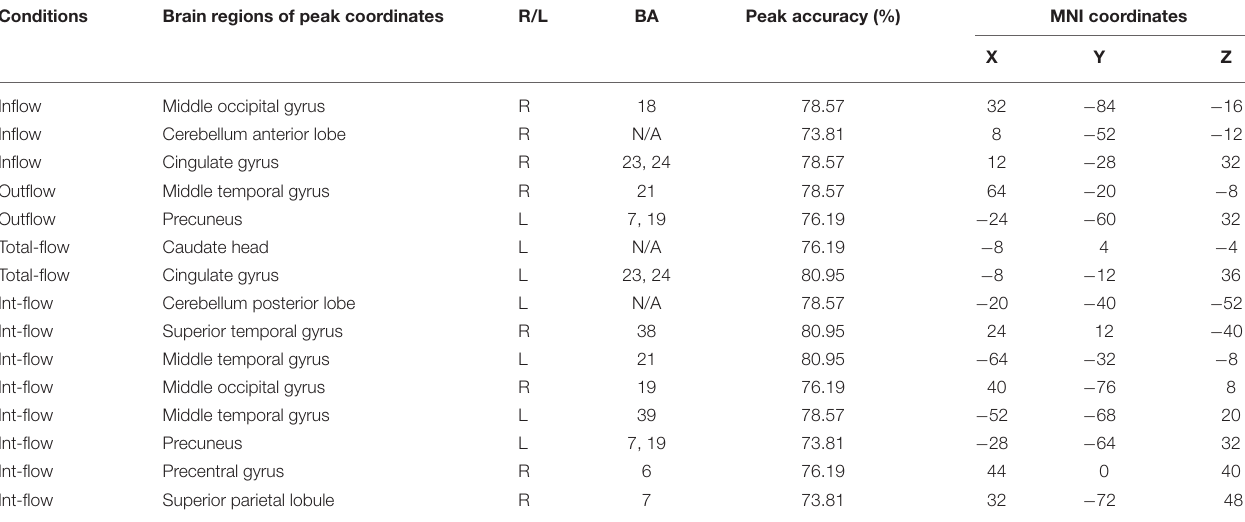
TABLE 2 | Most important brain regions discriminating between IEDs and non-IEDs substates.